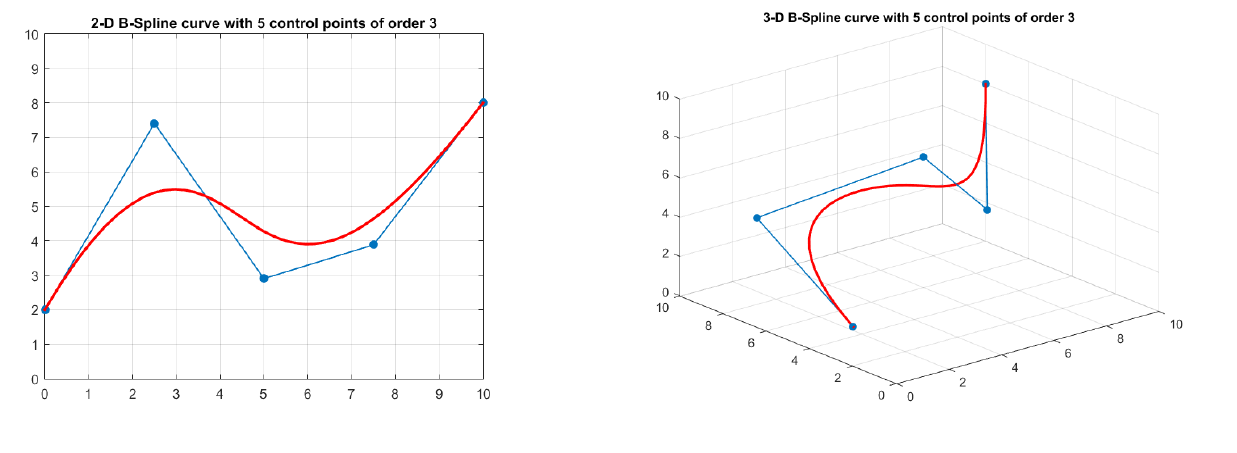
Figure 4. The cubic B-Spline curves and their control